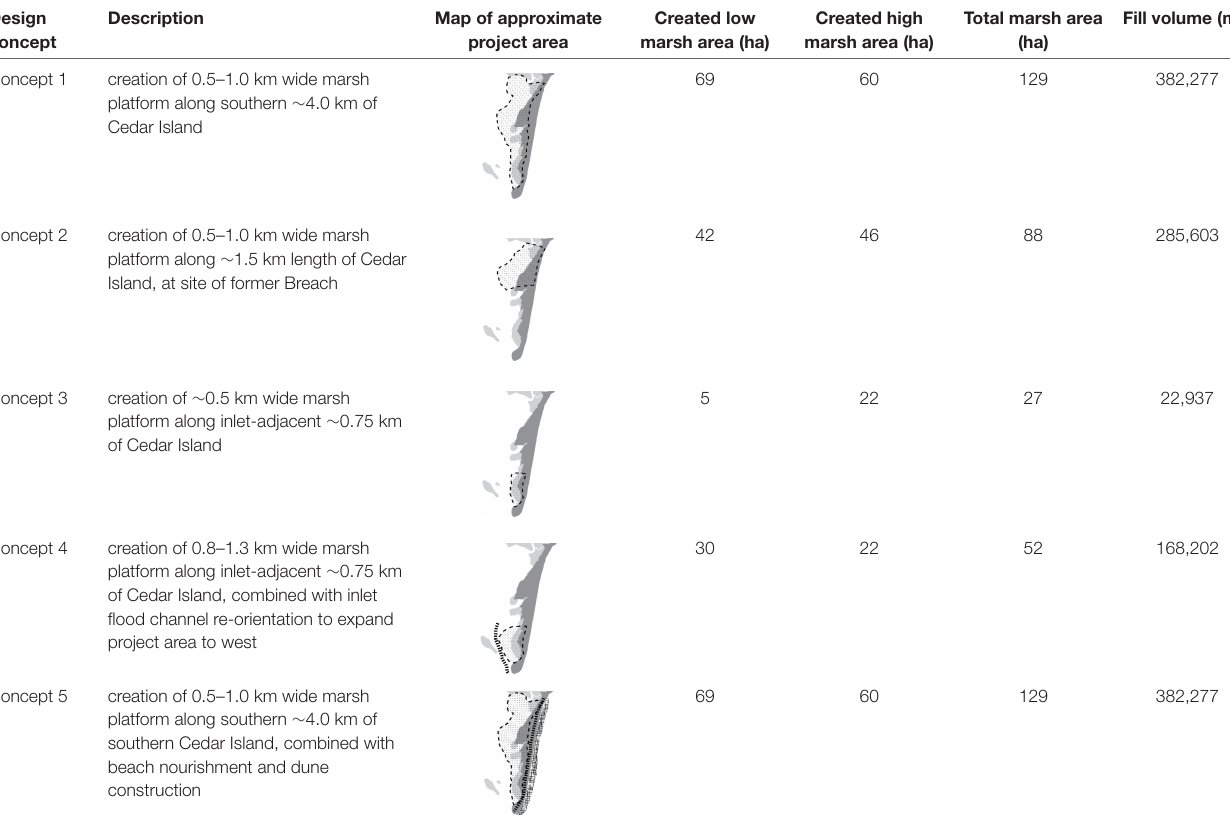
TABLE 1 | Comparison of preliminary design concepts considered for full